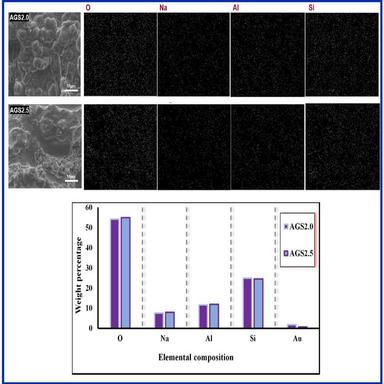
FESEM micrographs, elemental mapping with EDX analysis of geopolymer coating compositions after addition of amorphous silica.